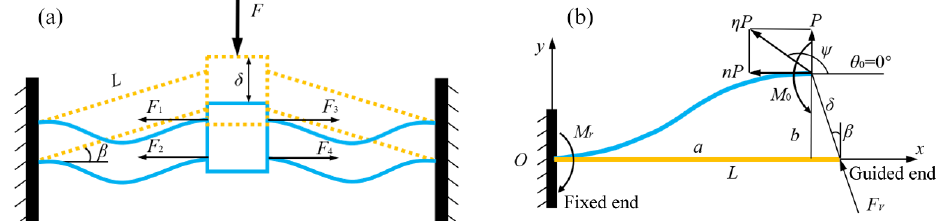
Figure 3. (a) Deformation and internal force of the bistable mechanism driven axially by the vertical force. (b) The deformation and external force of each fixed–guided beam during the movement of the bistable